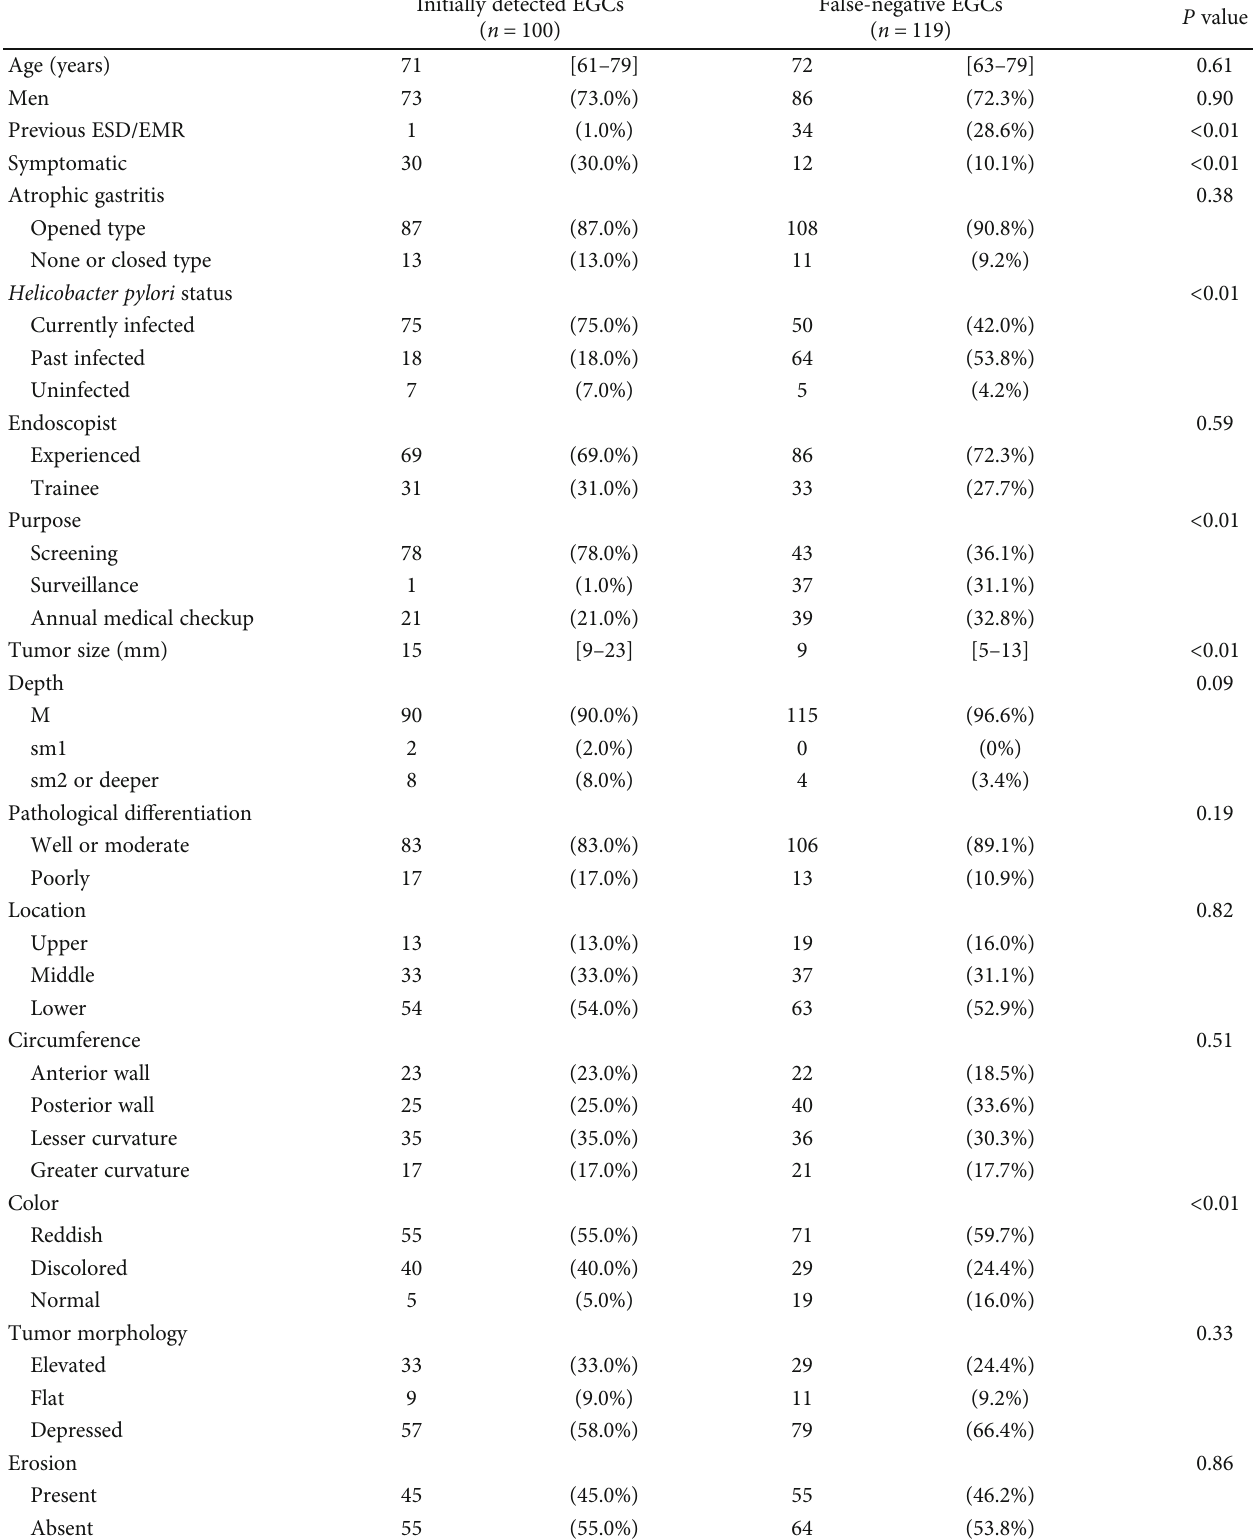
Table 1: Clinical characteristics in the initially detected and false-negative